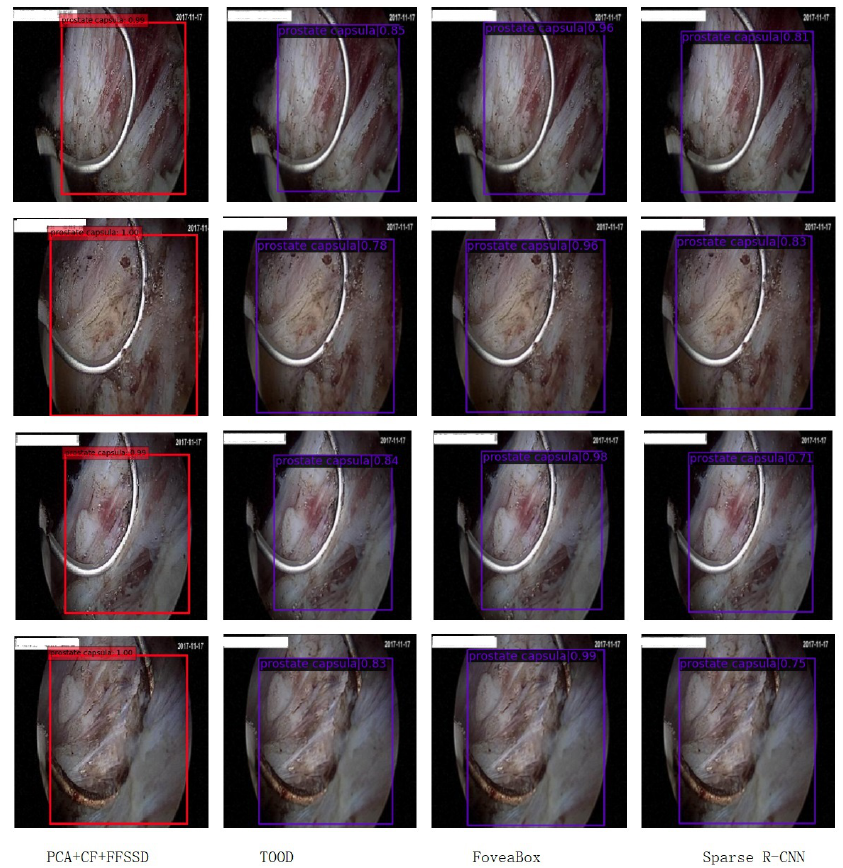
Figure 14. Detection result comparison for PCA+CF+FFSSD, TOOD, Sparse R-CNN, and FoveaBox. Compared with the original model, PCA+CF+FFSSD detects the location of the prostate capsule more